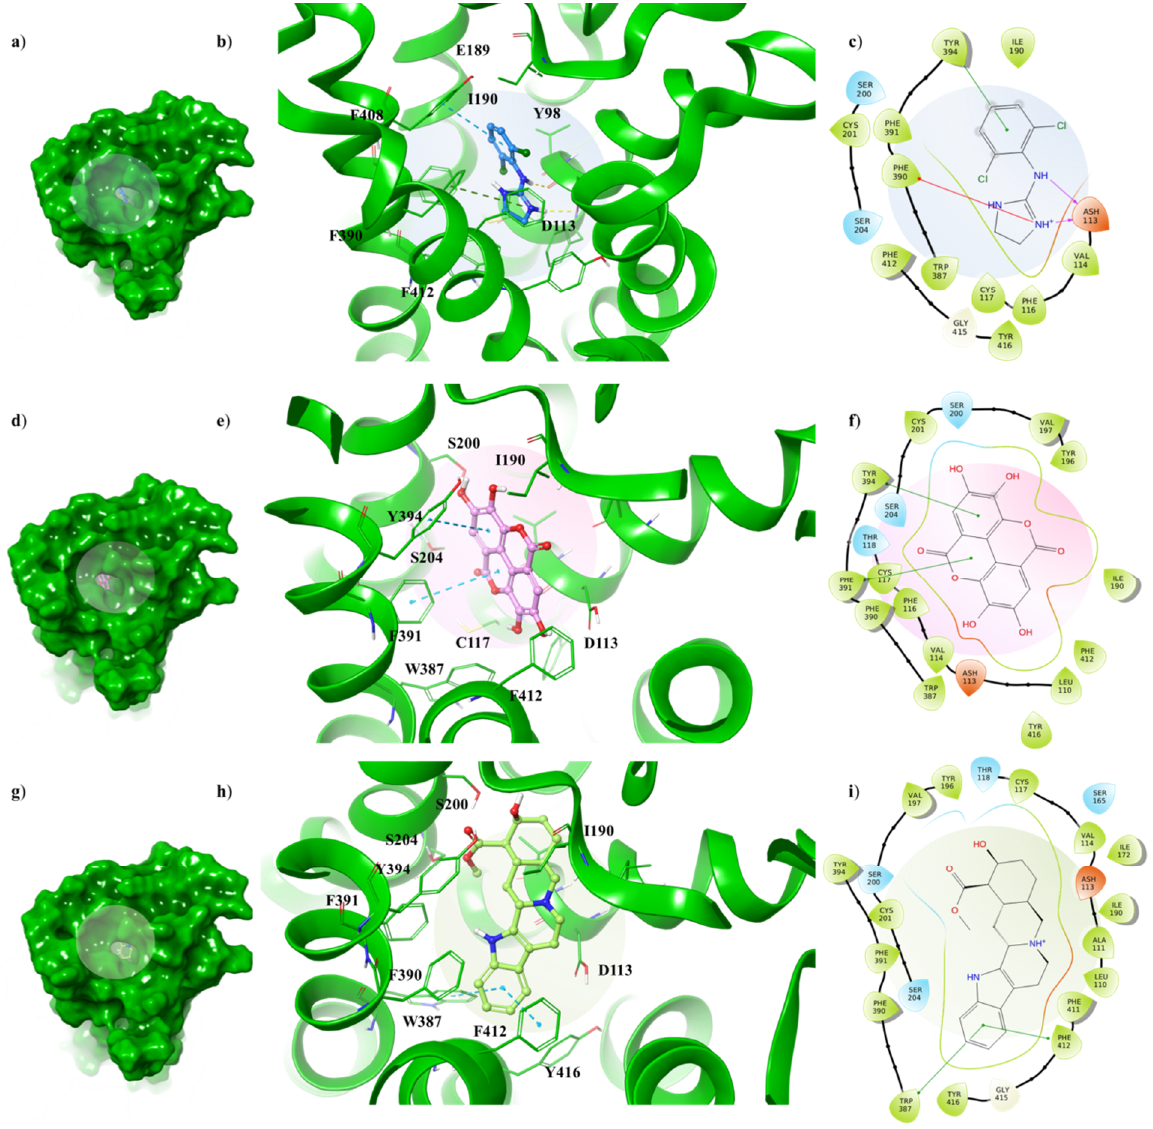
Figure 5. Key contacting elements inside ( a – c ) the α 2A -AR 6KUY /clonidine, ( d – f ) the α 2A -AR 6KUY /EA, and ( g – i ) the α 2A - AR 6KUY /yohimbine best docked pose. Panels ( b , e , h ) show all side chains involved in H-bonds (violet), π - π interactions (cyan) and π -cation interactions (red) in stick representation. Panels ( a , d,g ) show the surface area of α 2A -AR 6KUY complexed to clonidine, EA and yohimbine, respectively. The surface area of the receptor is shown in solid green. 2D representation of the key interactions of ( c ) clonidine, ( f ) EA and ( i ) yohimbine into the α 2A -AR 6KUY structure.